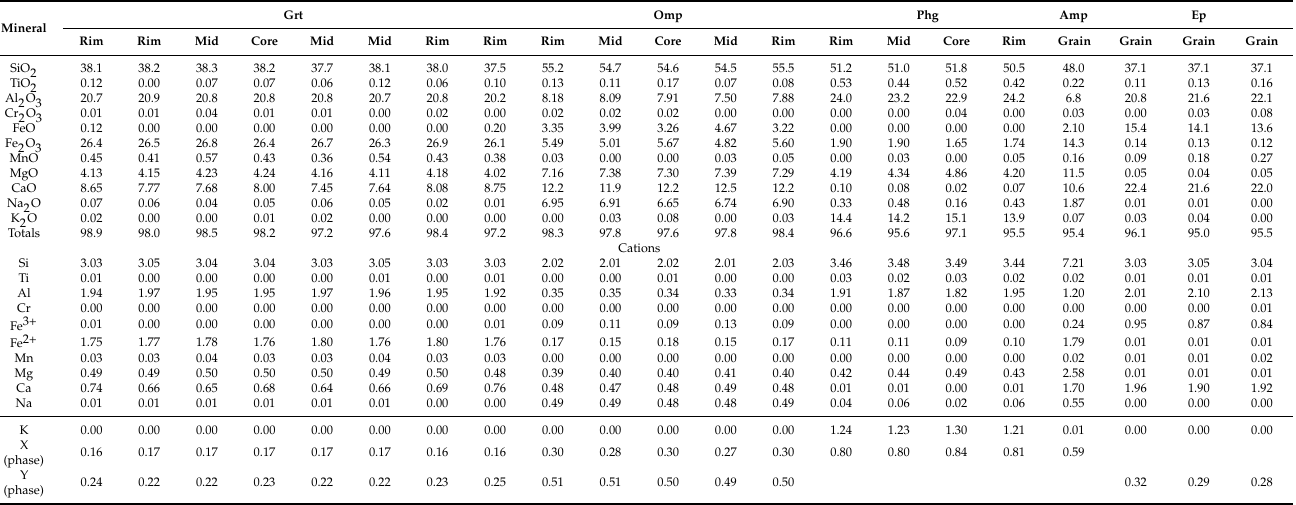
Table 2. Representative microprobe analyses for sample G-10 from the Guanshan